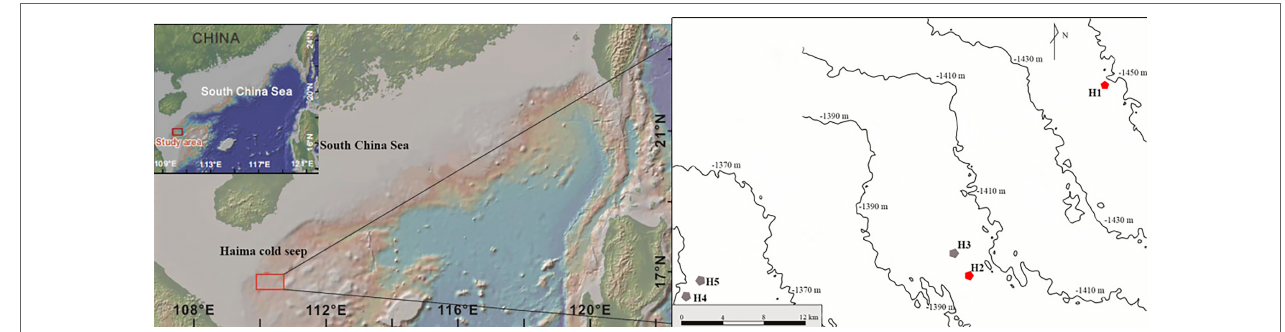
FIGURE 1 | Locations for sample collection of G. haimaensis . Five investigating sampling sites were set, only H1 and H2 that were marked by red hexagon were found to have G. haimaensis populations. H3, H4 and H5 in which no mussel population were marked by grey